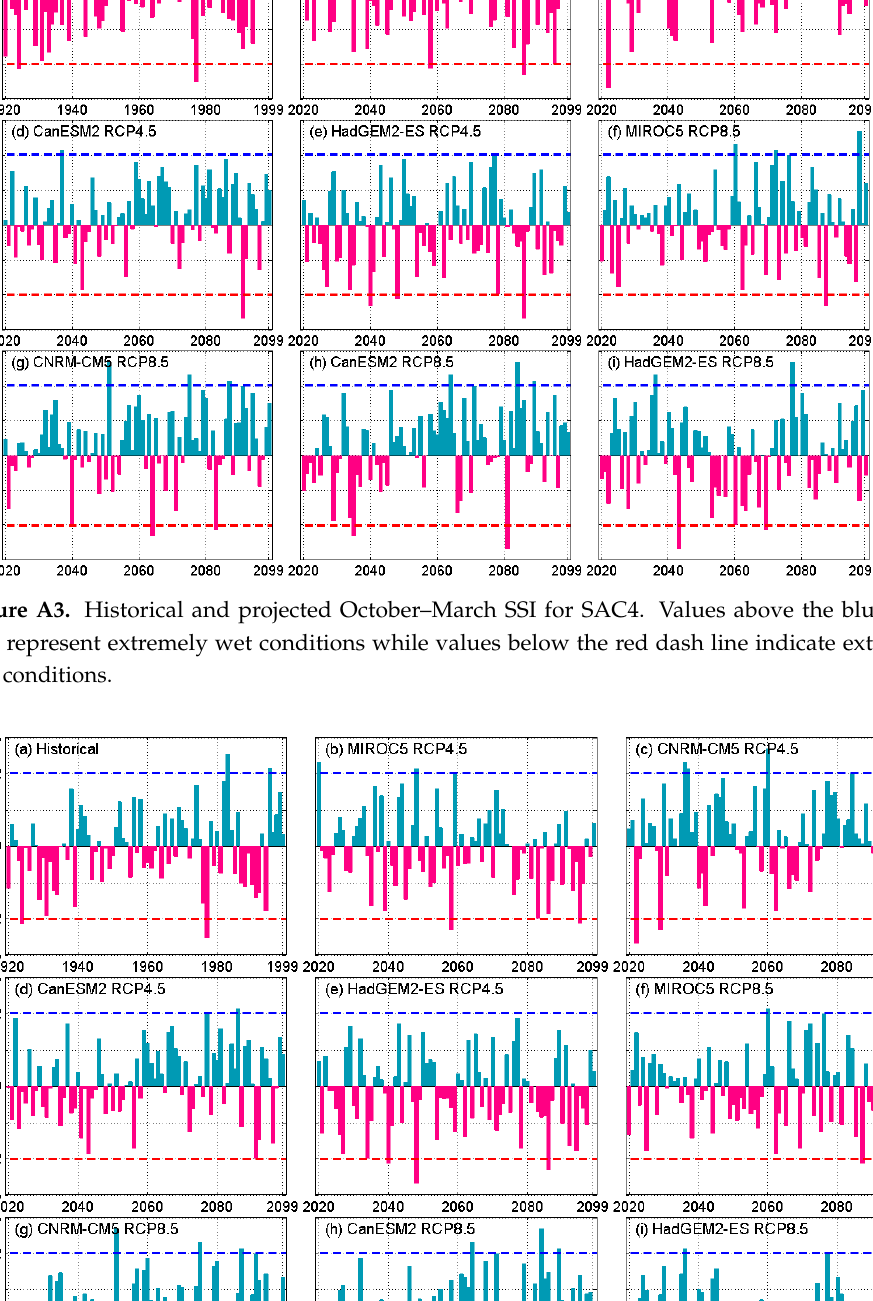
Figure A5. Historical and projected October–March SSI for SJQ4. Values above the blue dash line represent extremely wet conditions while values below the red dash line indicate extremely dry conditions.